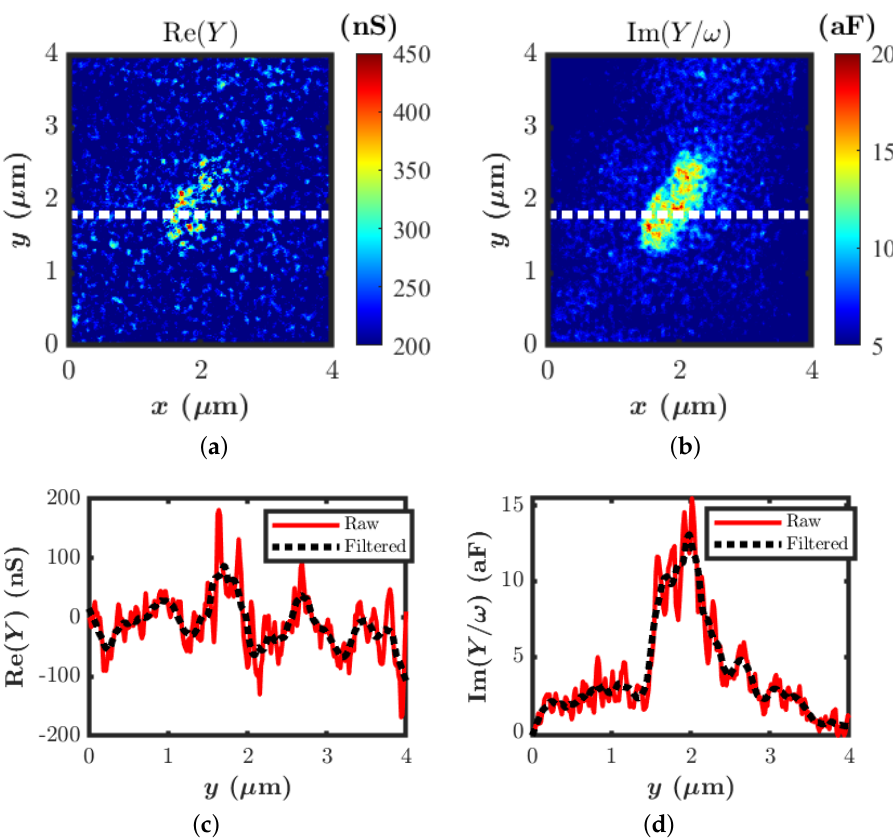
Figure 8. Calibrated local admittance. ( a ) Real part of the admittance. ( b ) Imaginary part of the admittance. ( c ) Line profile corresponding to the Re (Y) . ( d ) Line profile corresponding to the Im (Y)/ ω